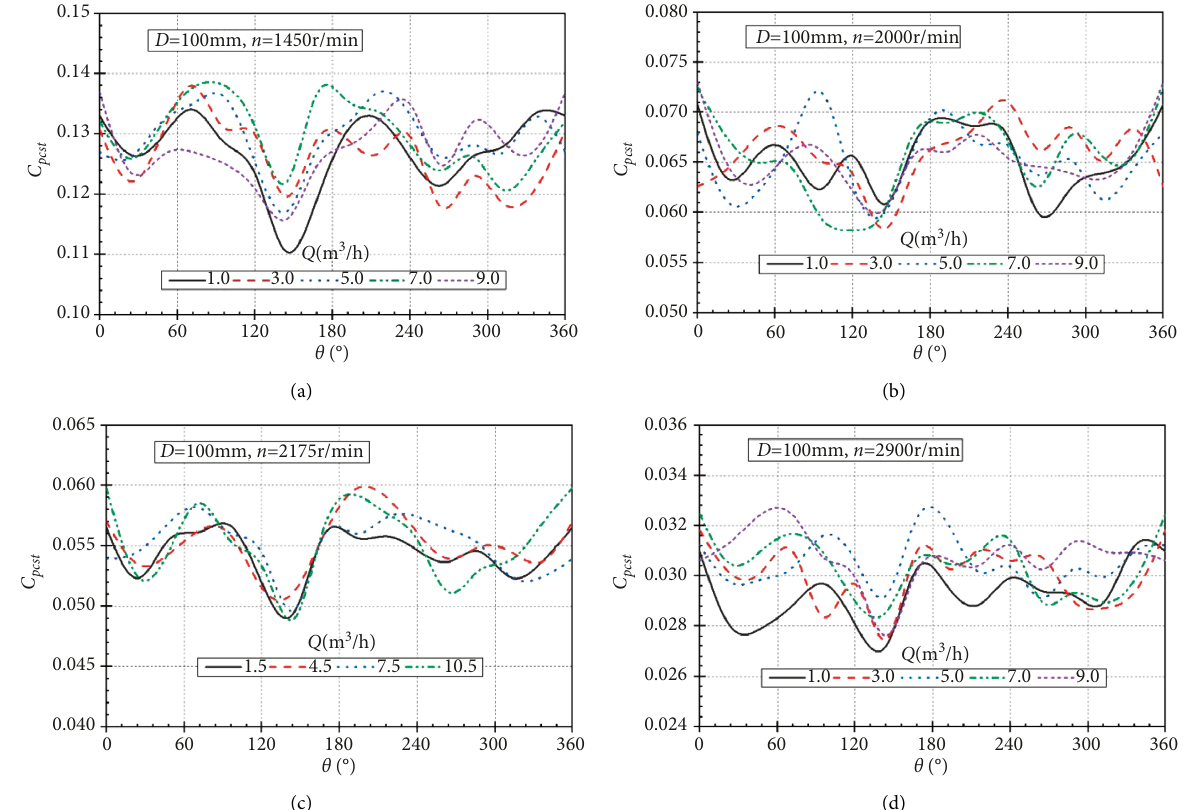
Figure 11: Pressure pulsation intensity of at the front wall of volute casing ( D �